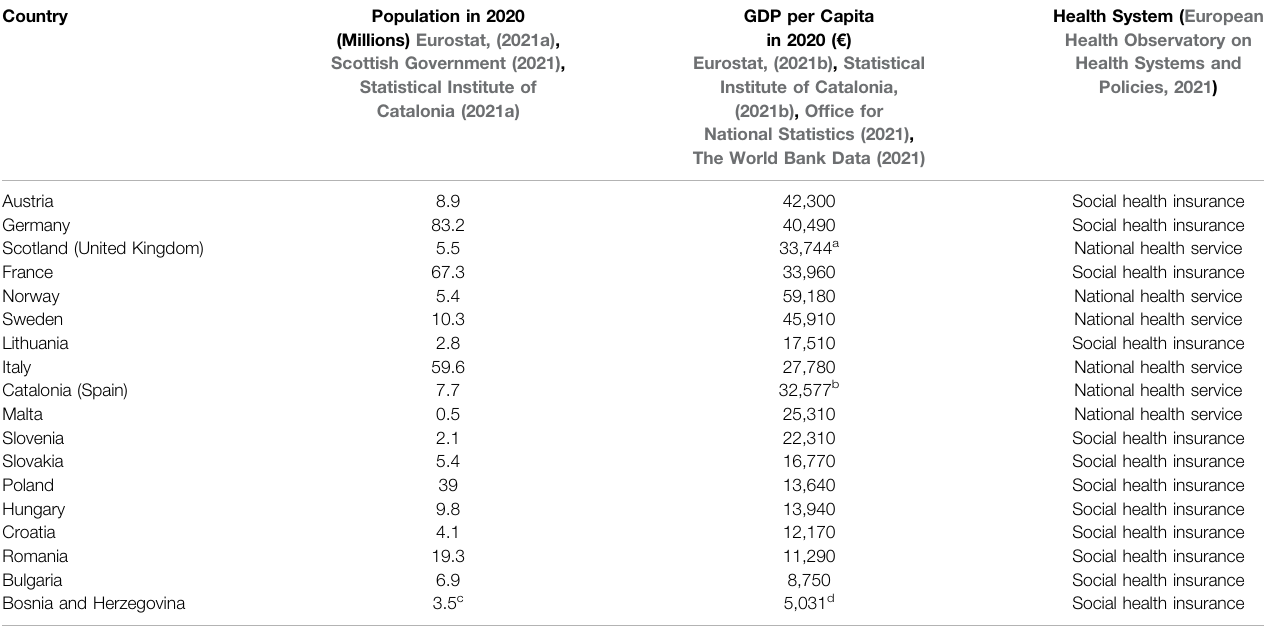
TABLE 1 | Country information broken down by population, economic power and type of health system.